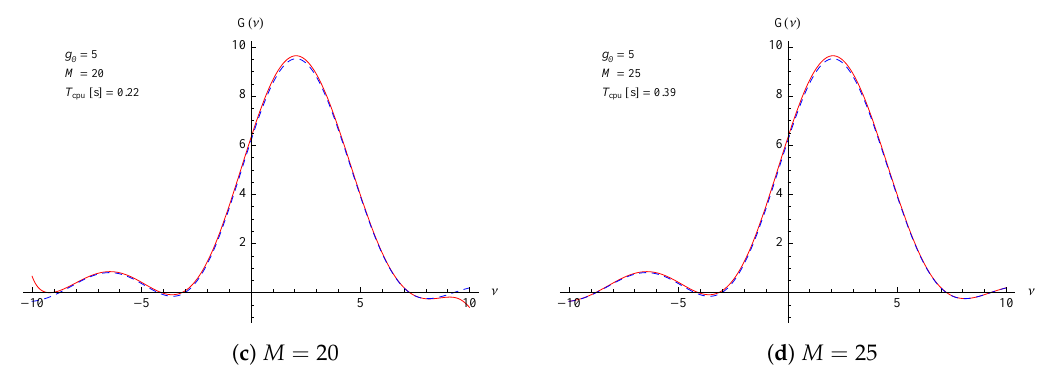
Figure 1. Comparison with the complete numerical integration (blue dashed line) at different truncation levels (M) and with no broadening effects ( µ ε = 0) and g 0 = 5. The CPU time used refers to an Intel I7 3 GHz processor.